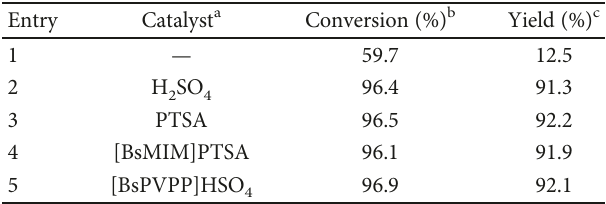
Table 2: Esteri fi cation of citric acid with n-butanol using di ff erent